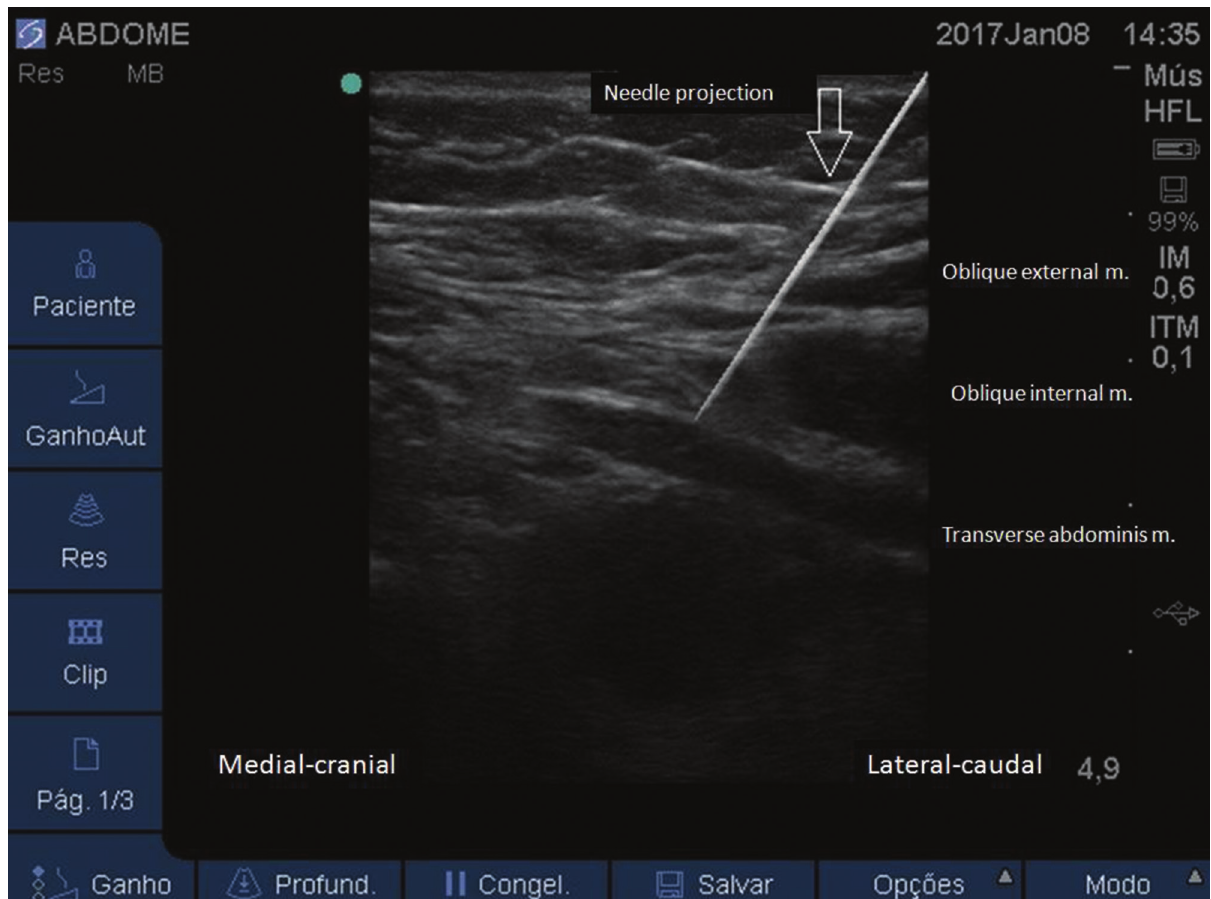
Figure 7 - Ultrasound image showing the proper position of the needle tip in the plane between the IO and TA muscles.